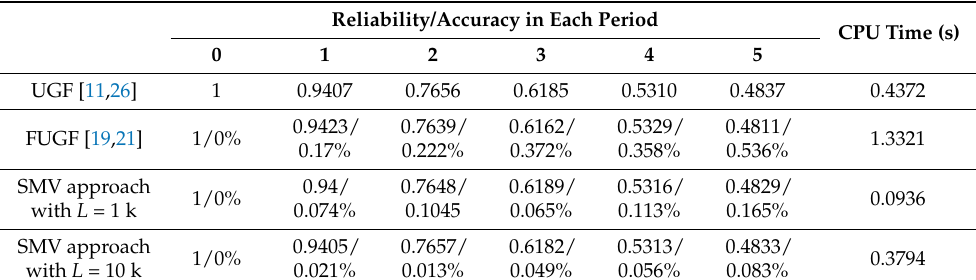
Table 9. The reliability and accuracy of a dynamic system of mode II in each period using UGF,